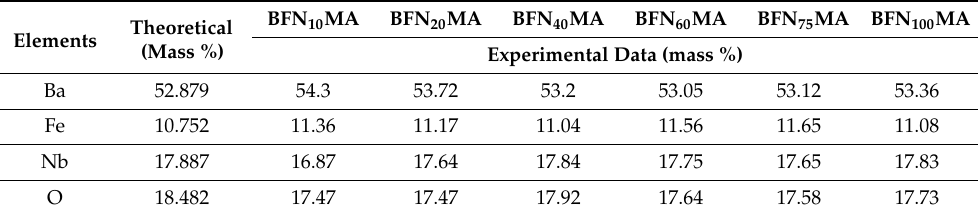
Table 1. Theoretical and experimental percentage of the individual components of the BFN x MA